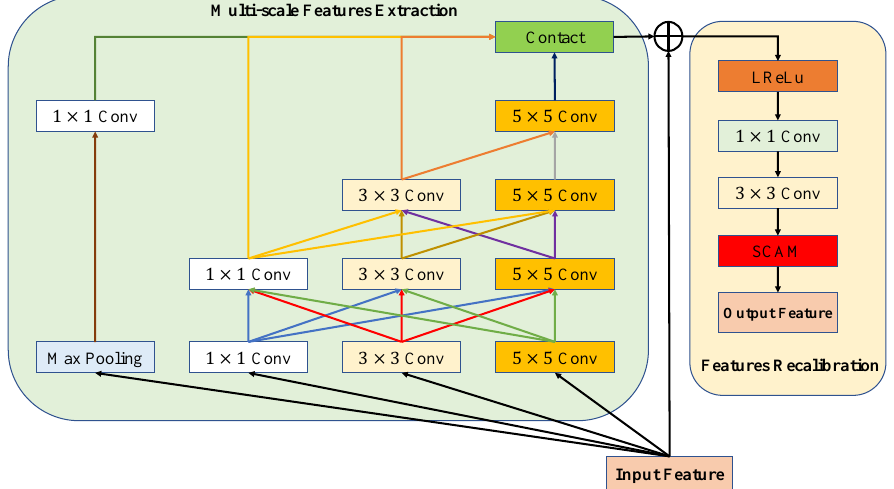
Figure 4. The proposed Multi-scale Extraction Recalibration